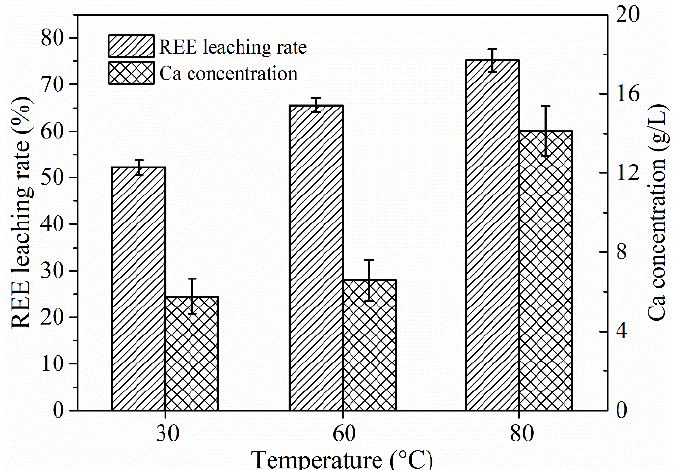
Figure 9. The effect of leaching temperature on REE leaching rate and calcium concentration at 1.65 mol/L HCl and S/L ratio of 1/10 for leaching 2 h.